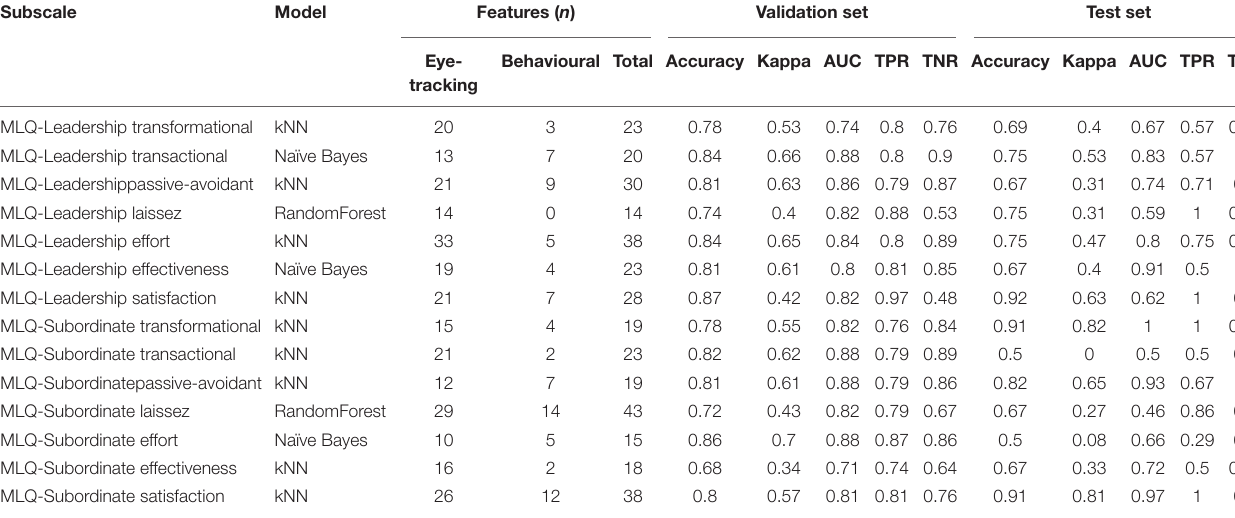
TABLE 5 | Metrics of the best ML model achieved for each MLQ subscale, both for the validation and the test set. Subscale Model Features ( n ) Validation set Test